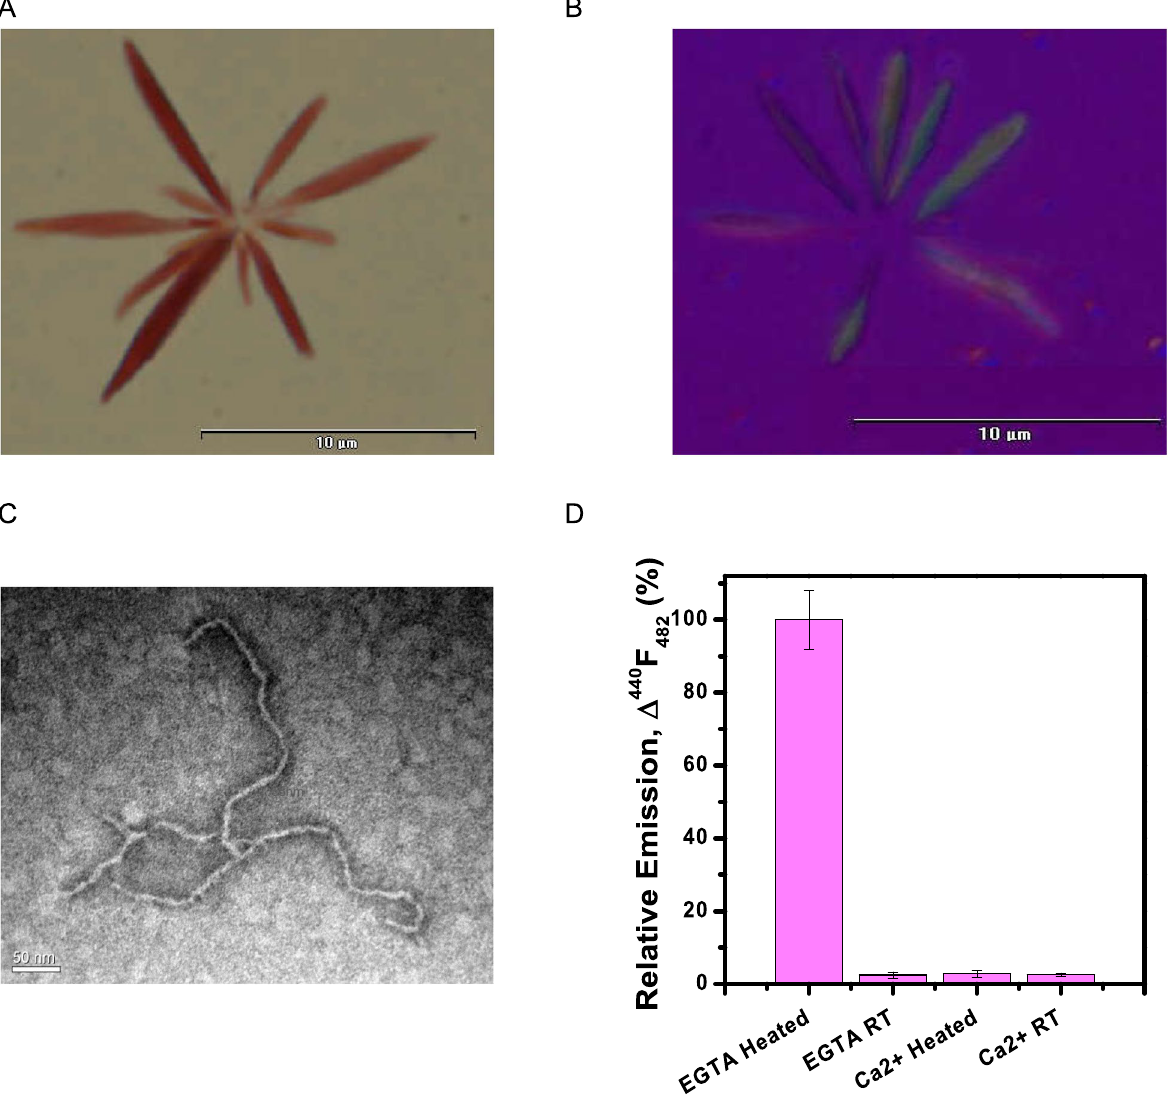
Figure 5. Characterization of heat induced amyloid formation of 28–161 under Ca 2 + free conditions. ( A ) Image taken under a light microscope, at 2000X showing pinkish red Congo red stained amyloid fibrils. ( B ) Image captured under cross polarizer confirming apple green birefringence characteristic of β -amyloidic nature of fibrils. ( C ) Image captured by TEM which showed long fibrils with a uniform width of 5–7 nm. ( D ) Relative emission observed in the ThT assay for different samples have been plotted